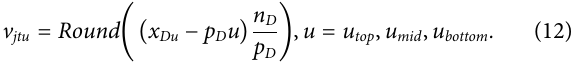
Frontiers in Physics |